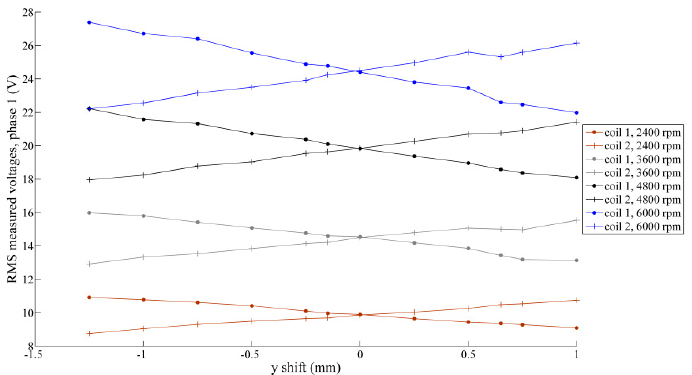
Figure 10. Root Mean square (RMS) value of first harmonic measured induced voltages at the coil terminals of phase 1, as a function of a rotor displacement along the y-axis, while centered along the x-axis, for rotor spin speeds of 2400, 3600, 4800, and 6000 rpm.